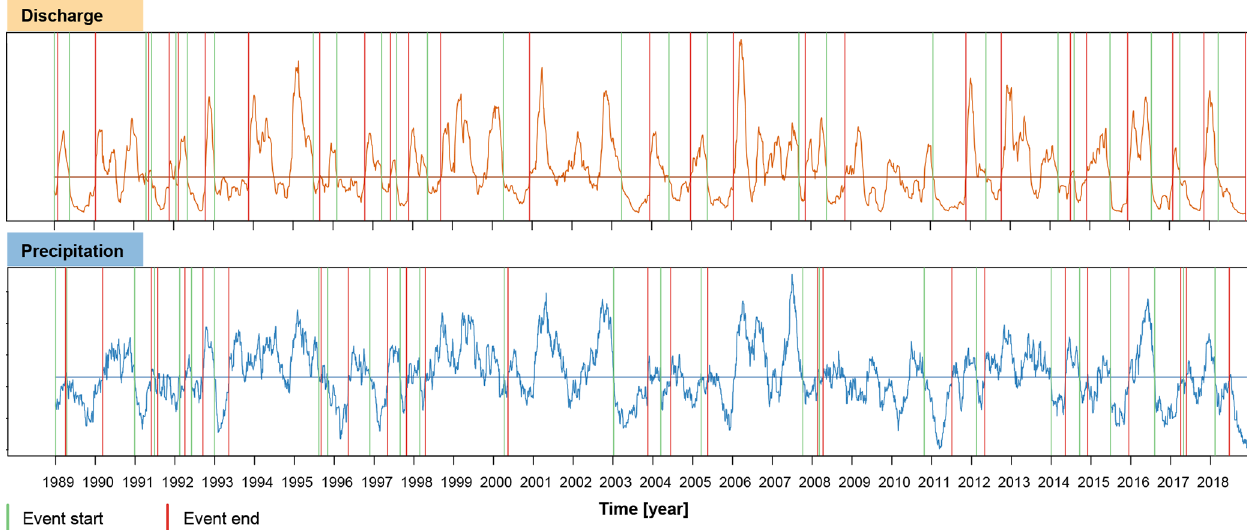
Figure 3. Extracted joint precipitation–discharge deficit events for the catchment Dünnern–Olten based on observed time series. The start of each joint event is indicated with a green line, and the end of each event with a red line. The thresholds (0.5 flow percentile) of the individual variables are indicated by horizontal lines.